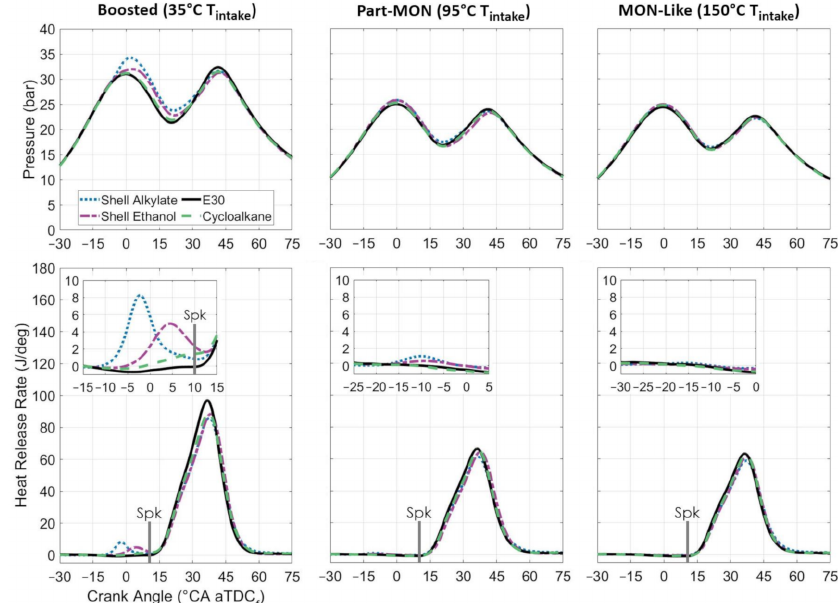
Figure 4. Pressure and heat release for Boosted, Part-MON, and MON-Like SI operation at a phasing of 35 ◦ CA aTDC f , spark timing is 10 ± 1 ◦ CA aTDC f for all